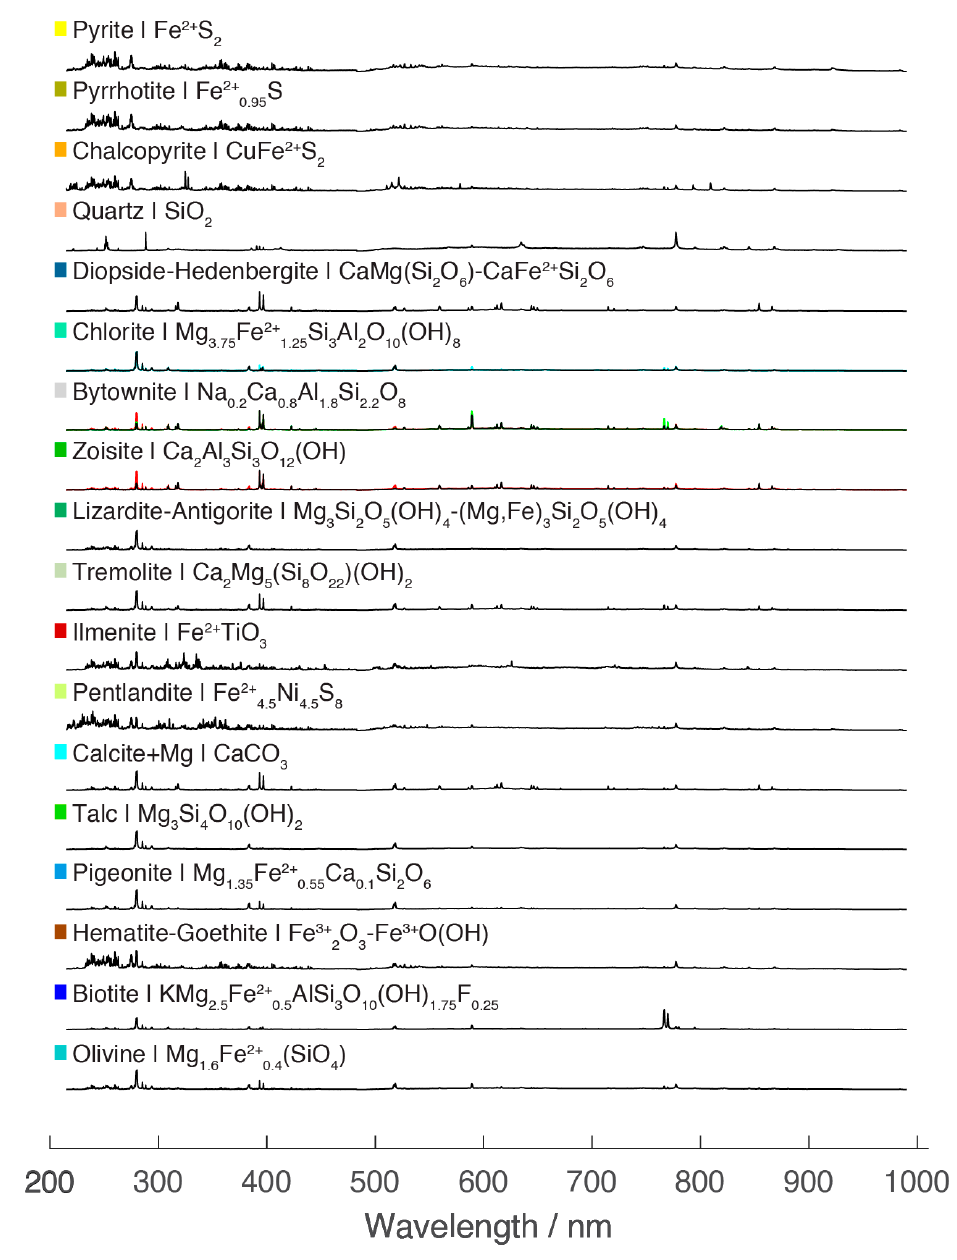
Figure 3. Mineral classes spectra in the 220–990 nm range.